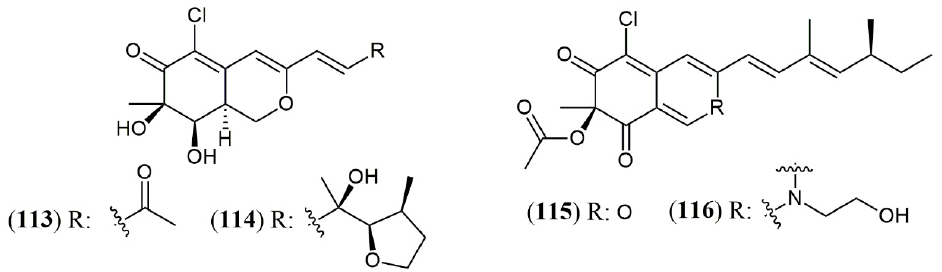
Figure 13. Halogenated azaphilones produced by marine and terrestrial fungi. 113–114 : penicilazaphilones D and E; 115 : sclerotiorin; 116 : N-ethylbenzene-sclerotioramine [95–96].